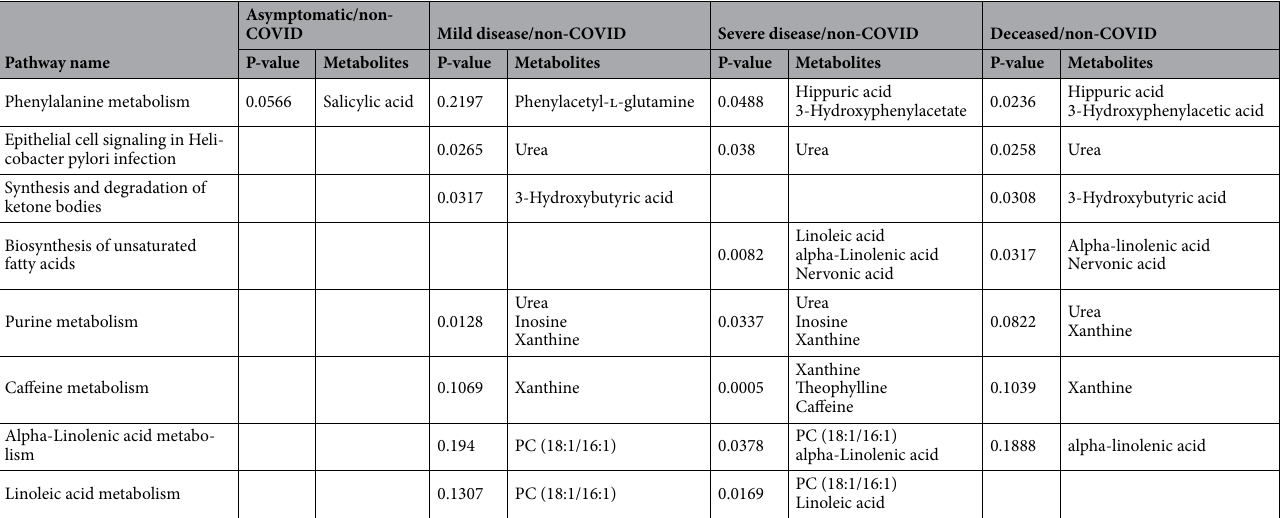
Table 1. Significantly enriched KEGG human metabolic pathways (in dark shade) from the analysis of significantly altered metabolites (after Mann–Whitney U test with p-value < 0.05) in asymptomatic, mild disease, severe disease and deceased COVID-19 positive groups as compared to non-COVID control